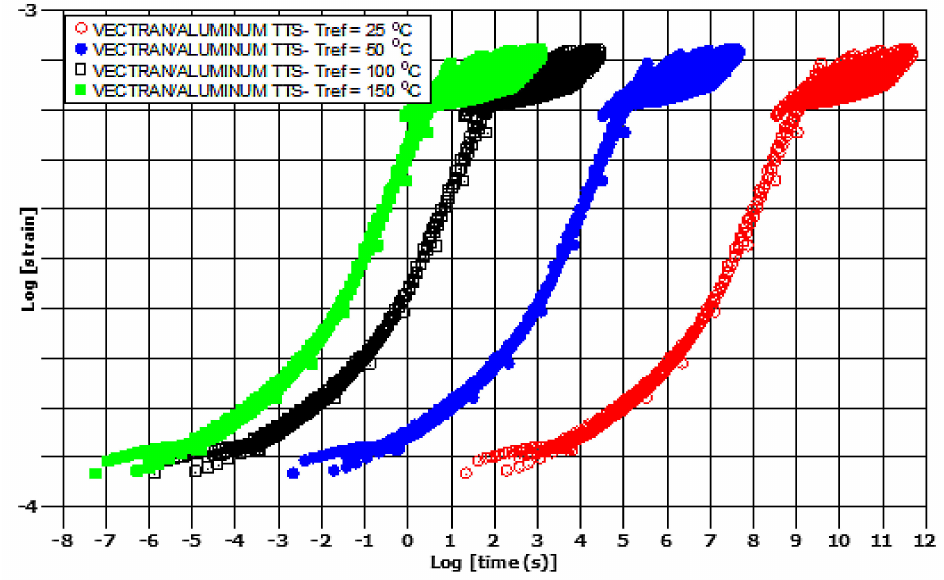
Figure 11. Vectran/aluminum–glass composite hybrid, creep TTS master